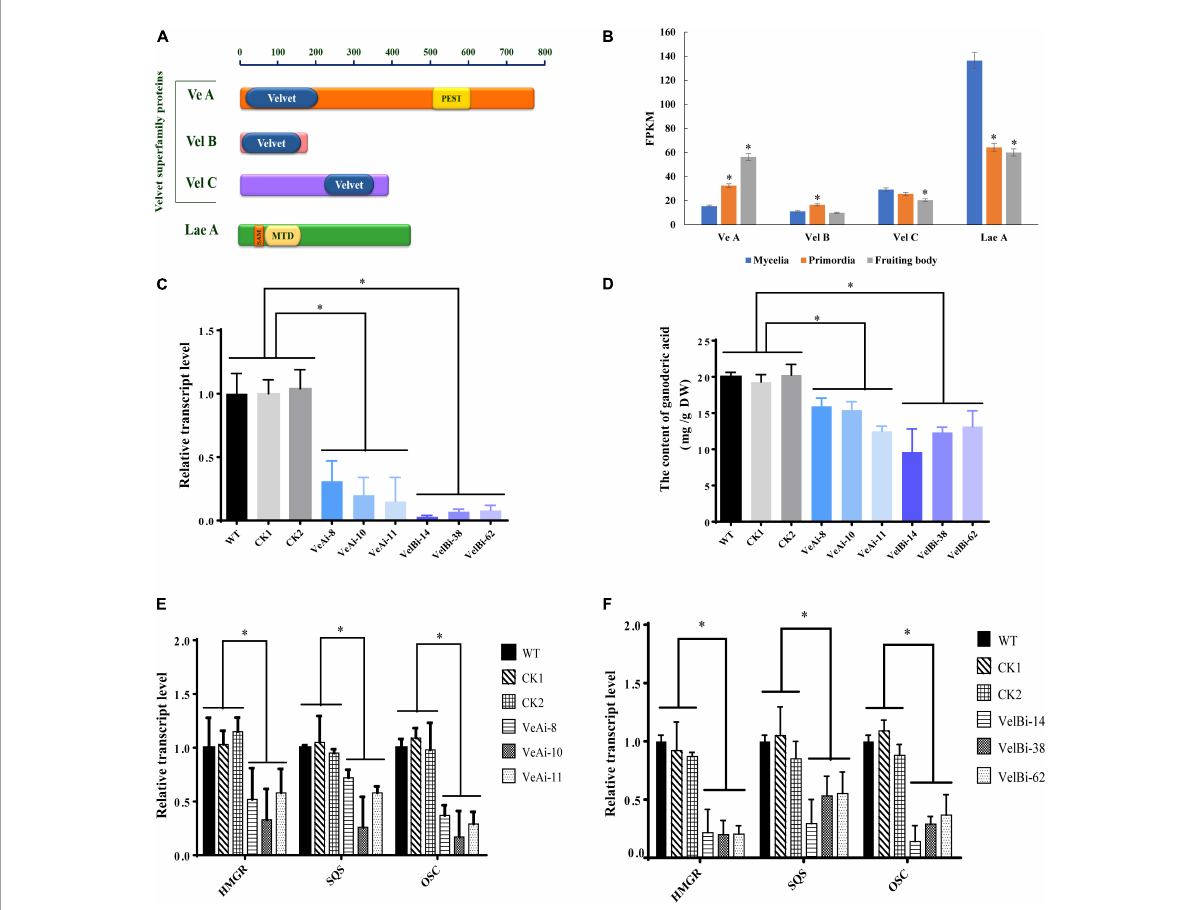
FIGURE6 The effects of velvet family on ganoderic acid biosynthesis in G. lucidum. Panel (A) is predicted conserved domains. Panel (B) the gene expression level in development of G. lucidum . FPKM, Fragments Per Kilobase Million. Panels (C,D) are the gene expression levels and GA contents of VeA and VelB. Panels (E,F) are the transcript levels of the genes encoding key enzymes. WT (wild-type), CK1 and CK2 (the empty vector controls), VeAi (8, 10, 11) and VelBi (14, 38, 62) were gene-silencing strains. HMGR, 3-hydroxy-3-methylglutaryl-coenzyme A reductase;